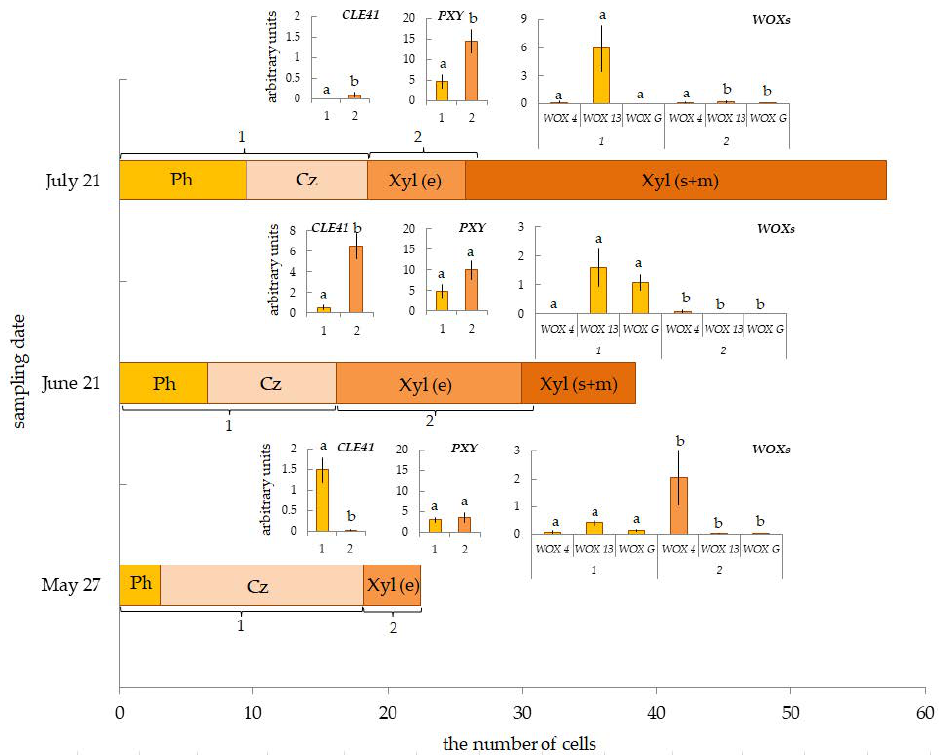
Figure 7. The number of cells in the radial row of conducting phloem (Ph), cambial zone (Cz), expanding cells (Xyl (e)) and cells that are forming secondary cell wall, and mature cells (Xyl (s+m)) of current year xylem in 40-year-old pine plants. Relative expression of genes CLE41/PXYWOXs in tissues, including the cambial zone, differentiating phloem and mature phloem (Fraction 1 (1)), and differentiating xylem (Fraction 2 (2)). Samples collected on 27 May, 21 June, and 21 July 2022. Different letters show differences only between Fraction 1 and Fraction